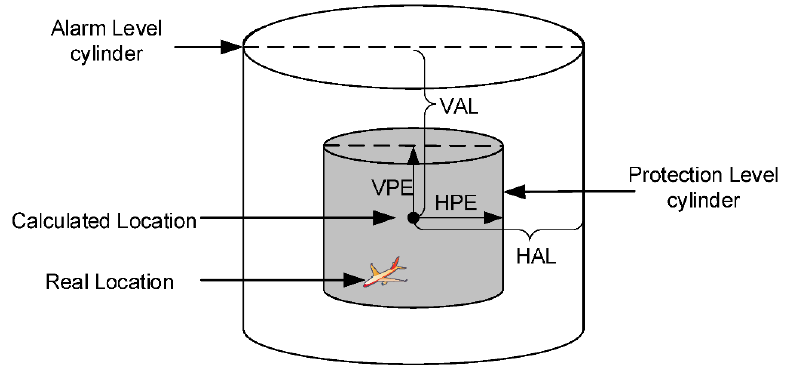
Figure 7. We used the cylinders to explain the status of the system service. When the protection level cylinder is inside the alarm level cylinder, the service is available. Otherwise, the service is unavailable. When the position error is within the protection level cylinder, missing alarms and integrity events will not occur in the service. Otherwise, missing alarms and integrity events may occur.